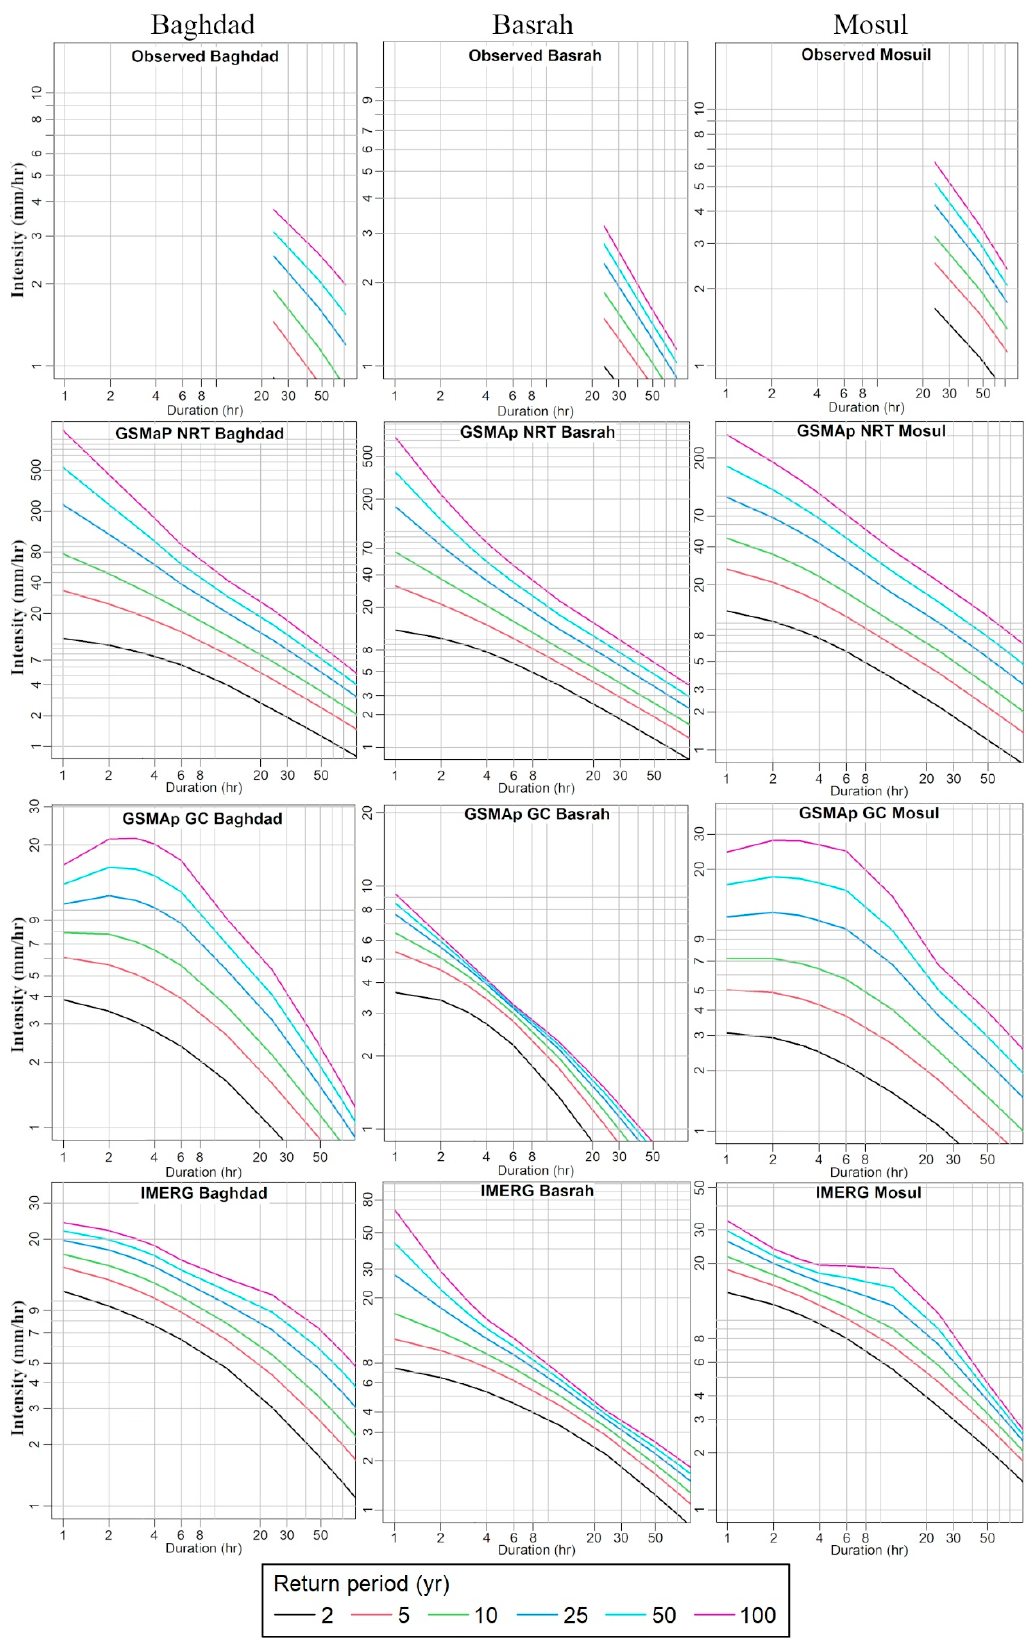
Figure 8. IDF curves at three Iraqi cities using satellite (GSMAp NRT, GSMAp GC, and IMERG) and observed rainfall data from 2000 to 2022.